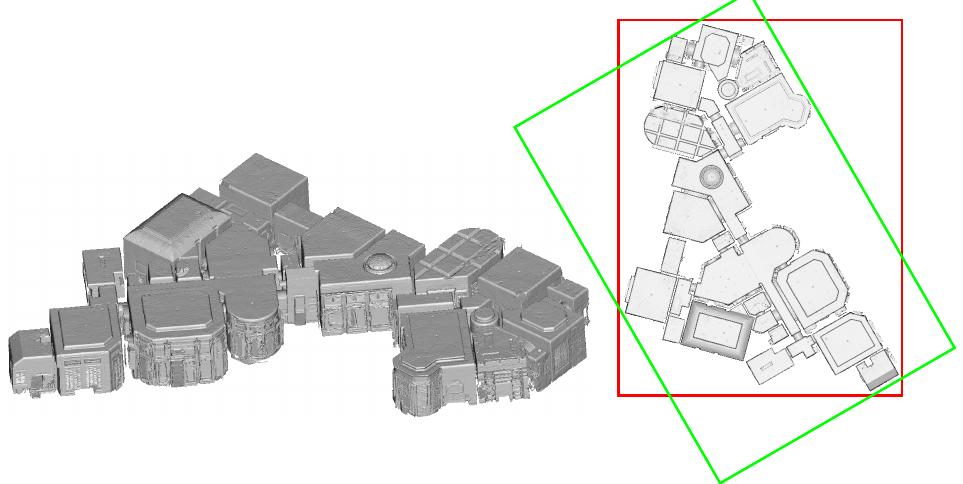
Figure 2. Exemplary triangle mesh of a building with multiple Manhattan World systems (dataset “mJXqzFtmKg4” from Matterport3D [90]). The green bounding box on the top-down-view on the right-hand side illustrates the alignment along the dominant Manhattan World structure, considered as the ground truth pose, while the red bounding box illustrates the pose rotated by 30° around the vertical axis, as exemplarily used in Section